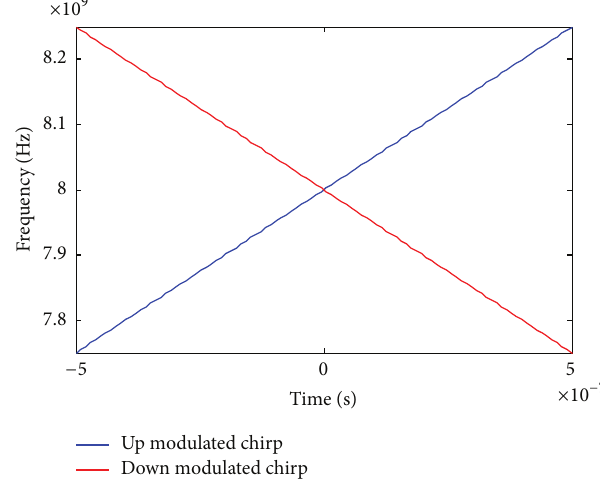
Figure 5: Transmitted